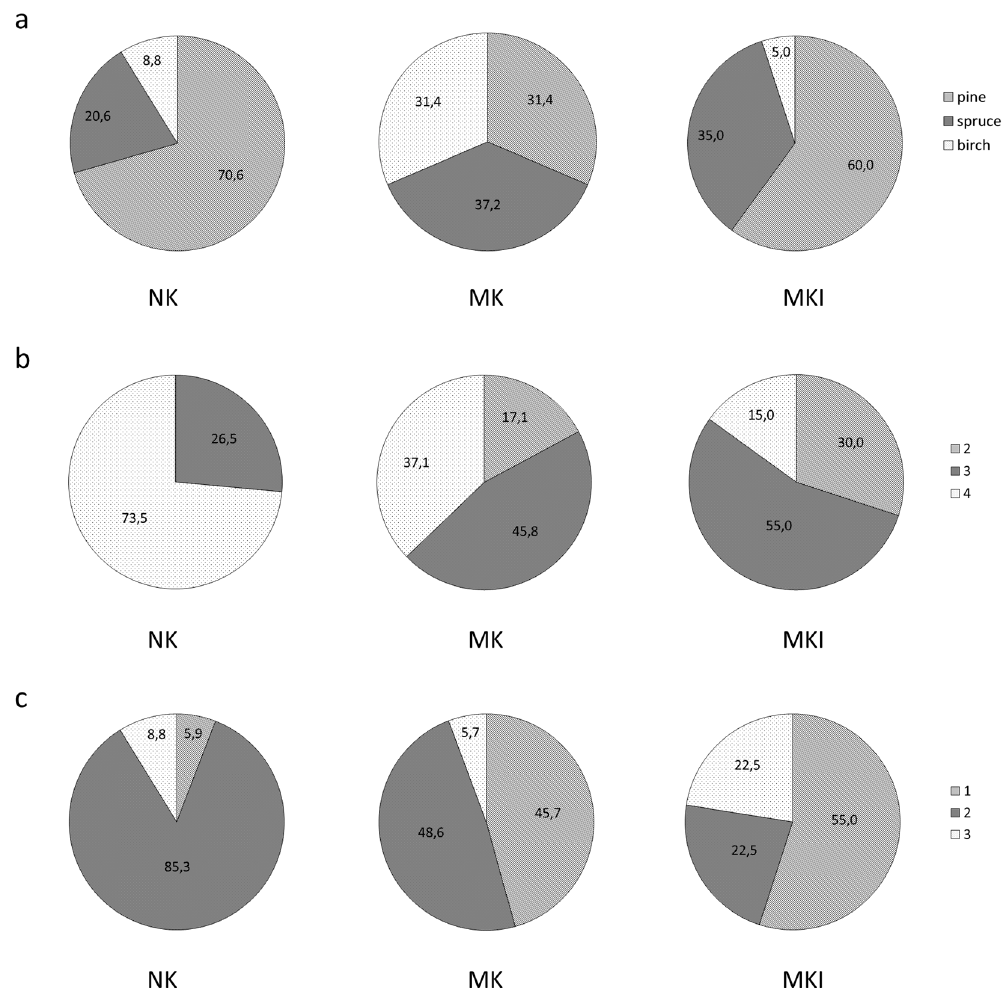
Figure 3. The proportion of ( a ) forest types, ( b ) Cajander’s site types: 2—Oxalis-Myrtillus, 3— Myrtillus, 4—Vaccinium vitis-idaea, and ( c ) plant functional types: 1—with a high proportion of